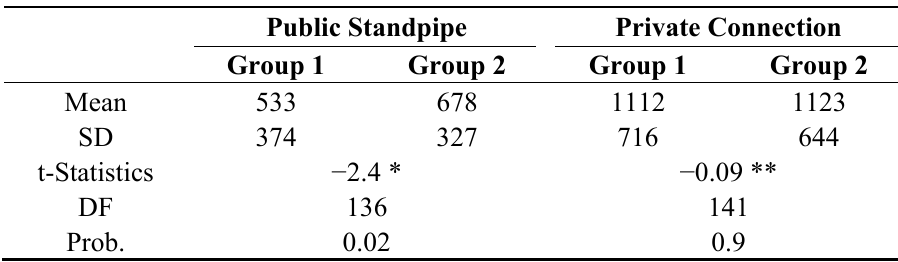
Table 3. Test results for strategic